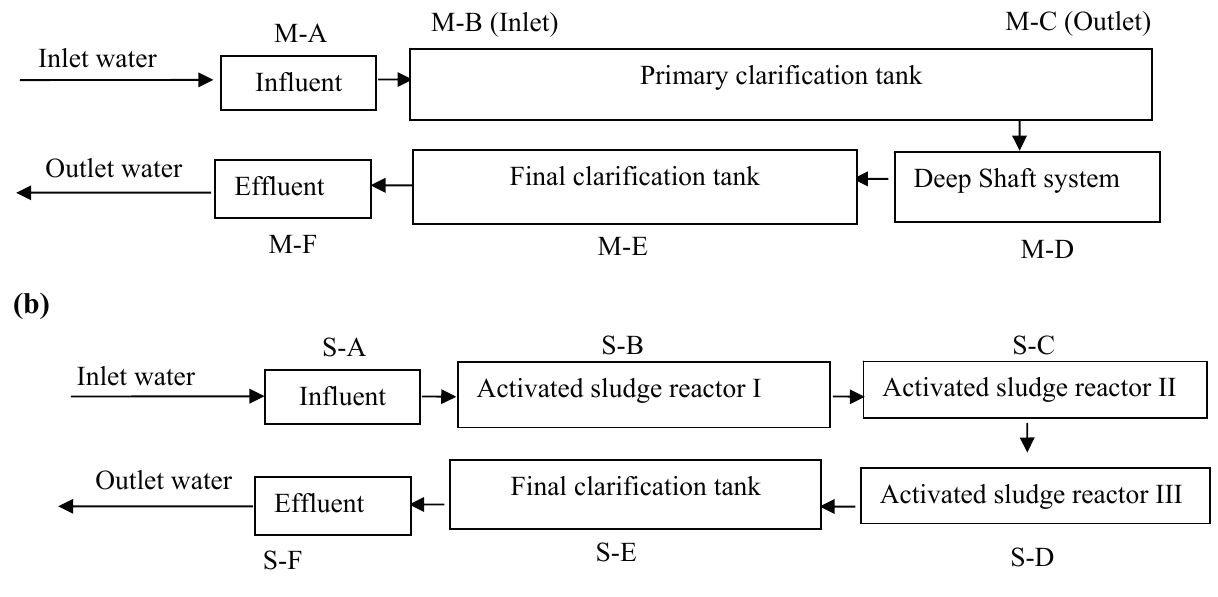
Figure 1. ( a ) Schematic drawing of the process at the municipal wastewater treatment plant, M-WWTP, and ( b ) the swine slaughterhouse wastewater treatment plant, S-WWTP